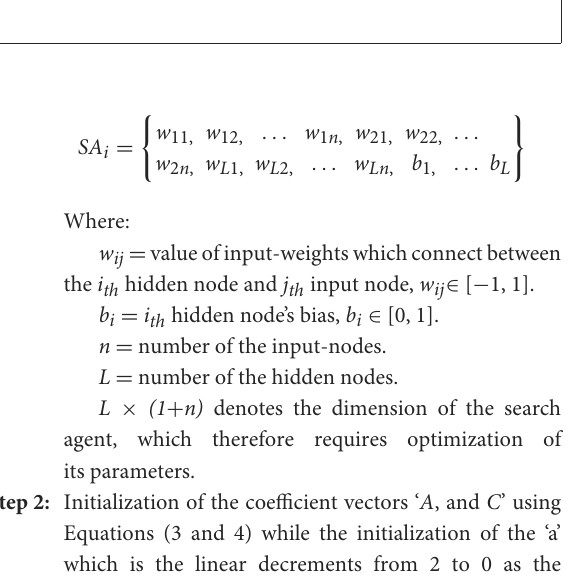
FIGURE5 GWO-ELM algorithm